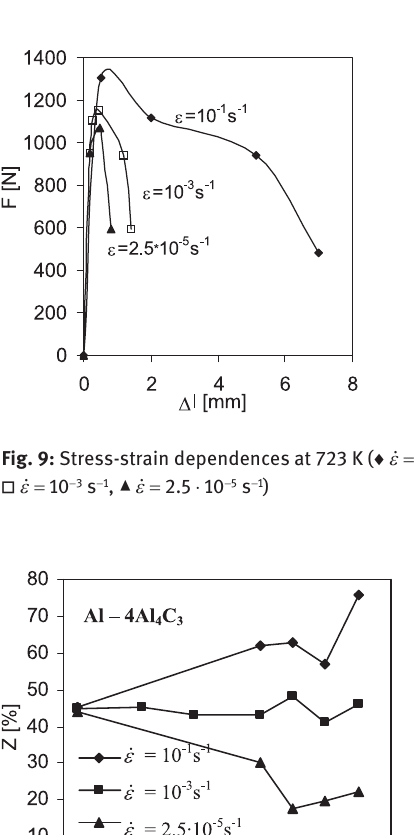
plastic deformation localization and fracture. On the other side curves for high strain rate and temperatures of 673 and 723 K showed after part I , a definitely linear part II with near constant true stress, sometimes called “plateau”,